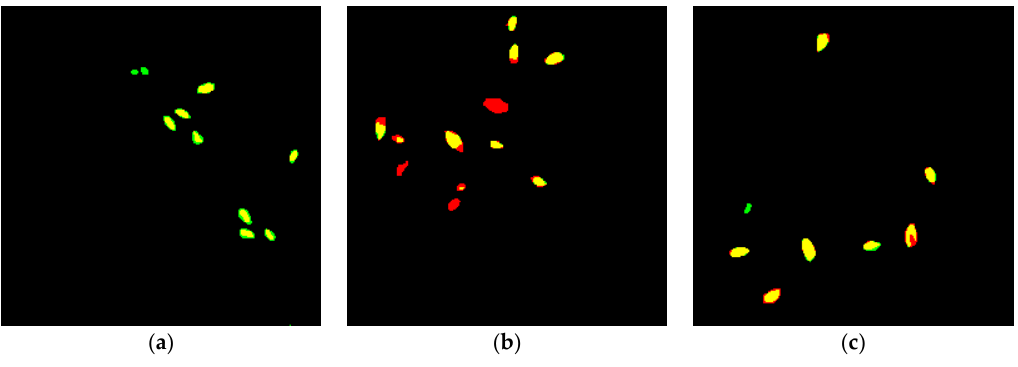
Figure 4. Typical failures of CNN segmentation. The first row shows CNN inputs. The second row shows the difference between corresponding CNN outputs and ground truth. The three cases are: ( a ) lesions on a leaf segmented as aphid nymphs; ( b ) aphid nymphs not segmented due to complicated lighting condition; ( c ) an exoskeleton segmented as an aphid nymph.